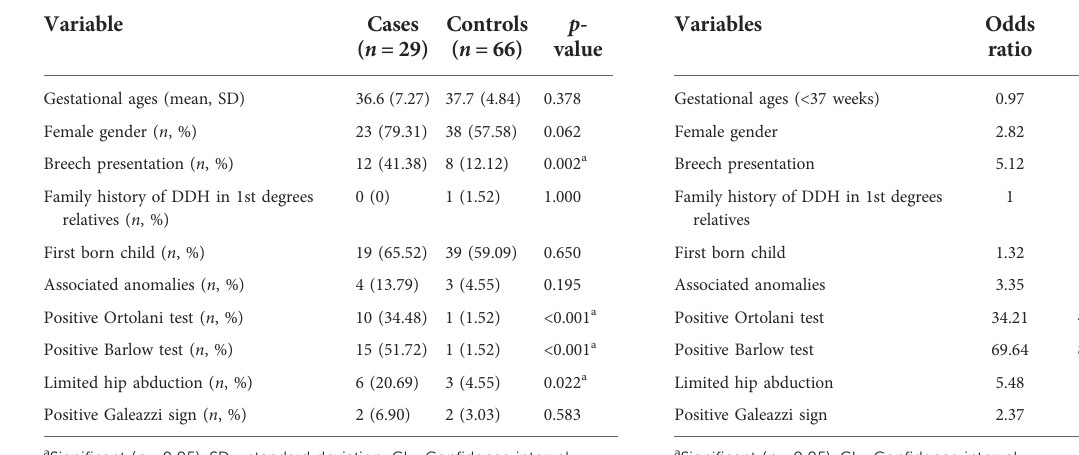
TABLE 1 Baseline characteristic.